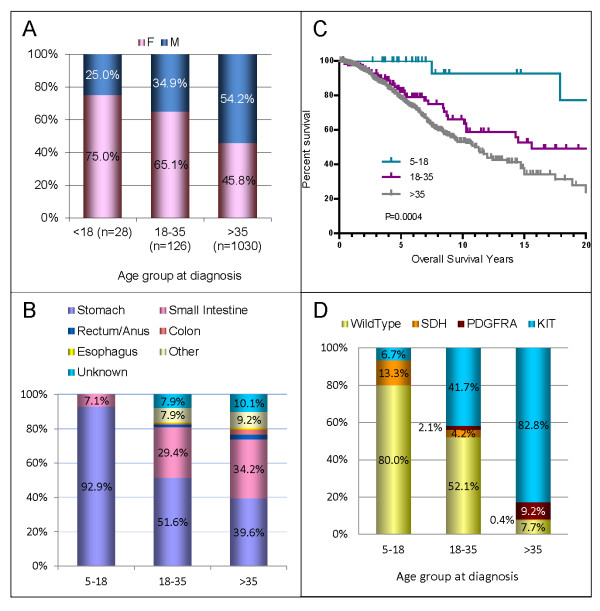
Patient and disease characteristics by age group at diagnosis. Patients diagnosed below the age of 18 had characteristics associated with pediatric-type GIST: female gender (panel A), predominantly stomach primaries (panel B), prolonged overall survival (panel C), and wild-type GISTor SDH mutations (panel D). Patients diagnosed over age 35 had characteristics associated with adult-type GIST: slight male preference (panel A), slight preference for stomach primary tumor location followed closely by small intestine primaries (panel B), shorter overall survival (panel C), and dominated by KIT mutations (panel D). The 18-35 at diagnosis age group had characteristics between those of pediatric-type and adult GIST. Tumor locations were provided as free text and are depicted as a relative percentage within each age-group (panel B). Some sites have been grouped post hoc including, multiple GI (stomach and esophagus, stomach and small intestine, small and large intestine), and "other" which includes all remaining reported primary tumor sites (table 2); the rest were as reported (esophagus, stomach, small intestine, colon or rectum/anus). This was an attempt to adhere to published groupings without changing the data as reported. Multi GI, colon, and rectum/anus in the > 35 group, and multi GI in the 18-35 group were ~3% (2.9-3.3%); the remaining unlabelled sites were all < 2% of age-group (0.8-1.6%).